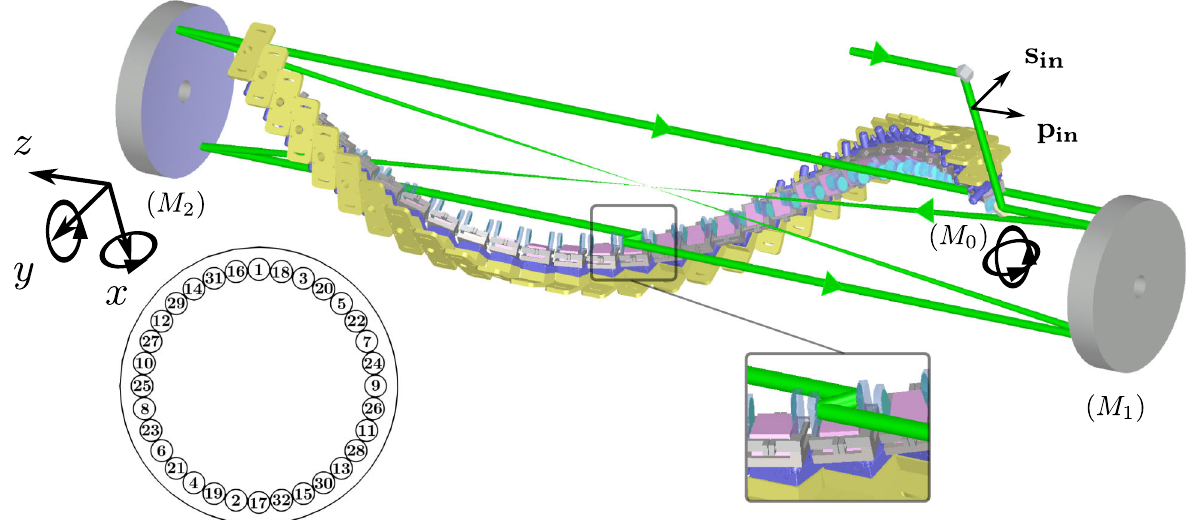
FIG. 2. Isometric view of ELI-NP-GBS recirculator. The mirror M 0 is used to inject the incident laser beam. The mirror-pair system (structures positioned on a circular helix) and the laser beam paths (green lines) are located between two parabolic mirrors M 1 , M 2 . Two of the 32 recirculation passes (green lines) are drawn. The polarization vectors s in and p in related to the incoming laser beam are also shown. The 7 degrees of freedom for the mirror motions are sketched: two tilts for M 0 ; two tilts and three translations for M 2 . The inset scheme shows the optical pass ordering.